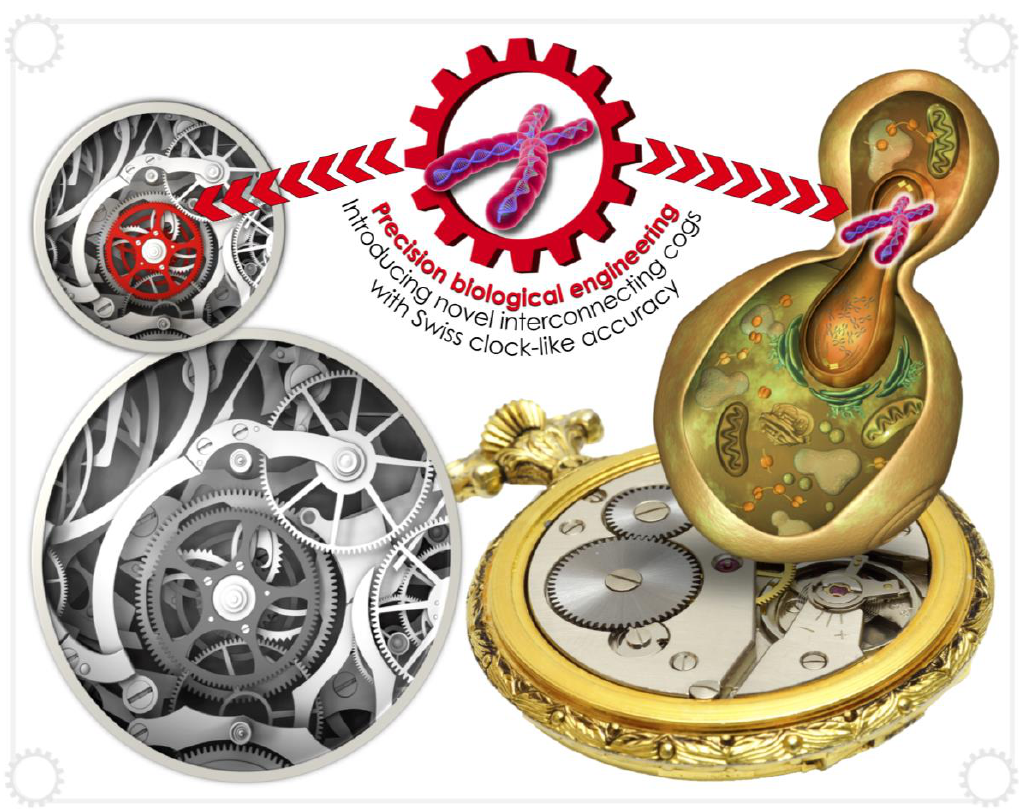
Figure 2. Saccharomyces cerevisiae is the predominant yeast species used in synthetic biology. Its well-